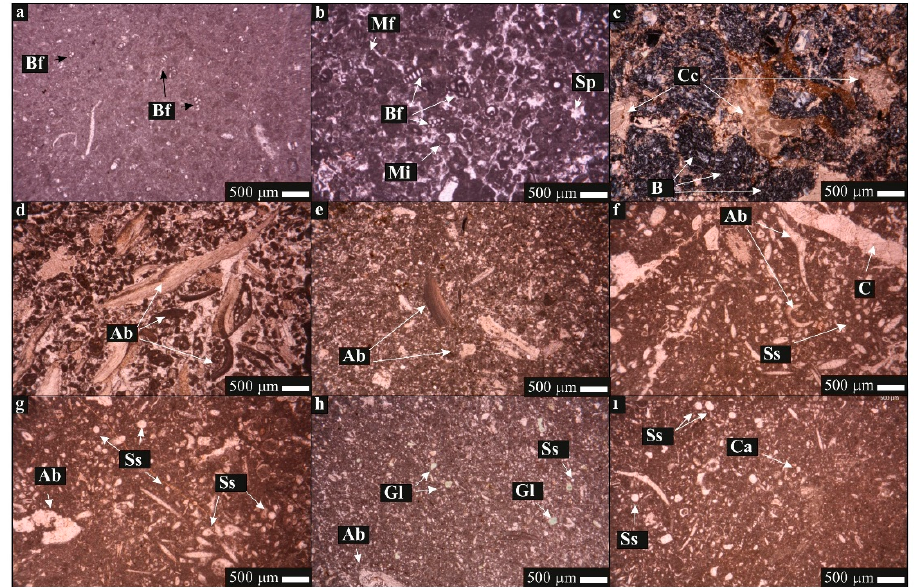
Figure 4. Benthic foraminiferal packstone microfacies (MF-1) ( a , b ). The transition zone between MF-1 and MF-2, showing basalt extraclasts and carbonate components ( c ). Reworked skeletal grainstone/packstone microfacies (MF-2) ( d – f ). Sponge spicule wackestone-mudstone microfacies (MF-3) ( g – i ). Bf: benthic foraminifera, Mf: micritized foraminifera, Mi: miliolid, Sp: sparite, Cc: